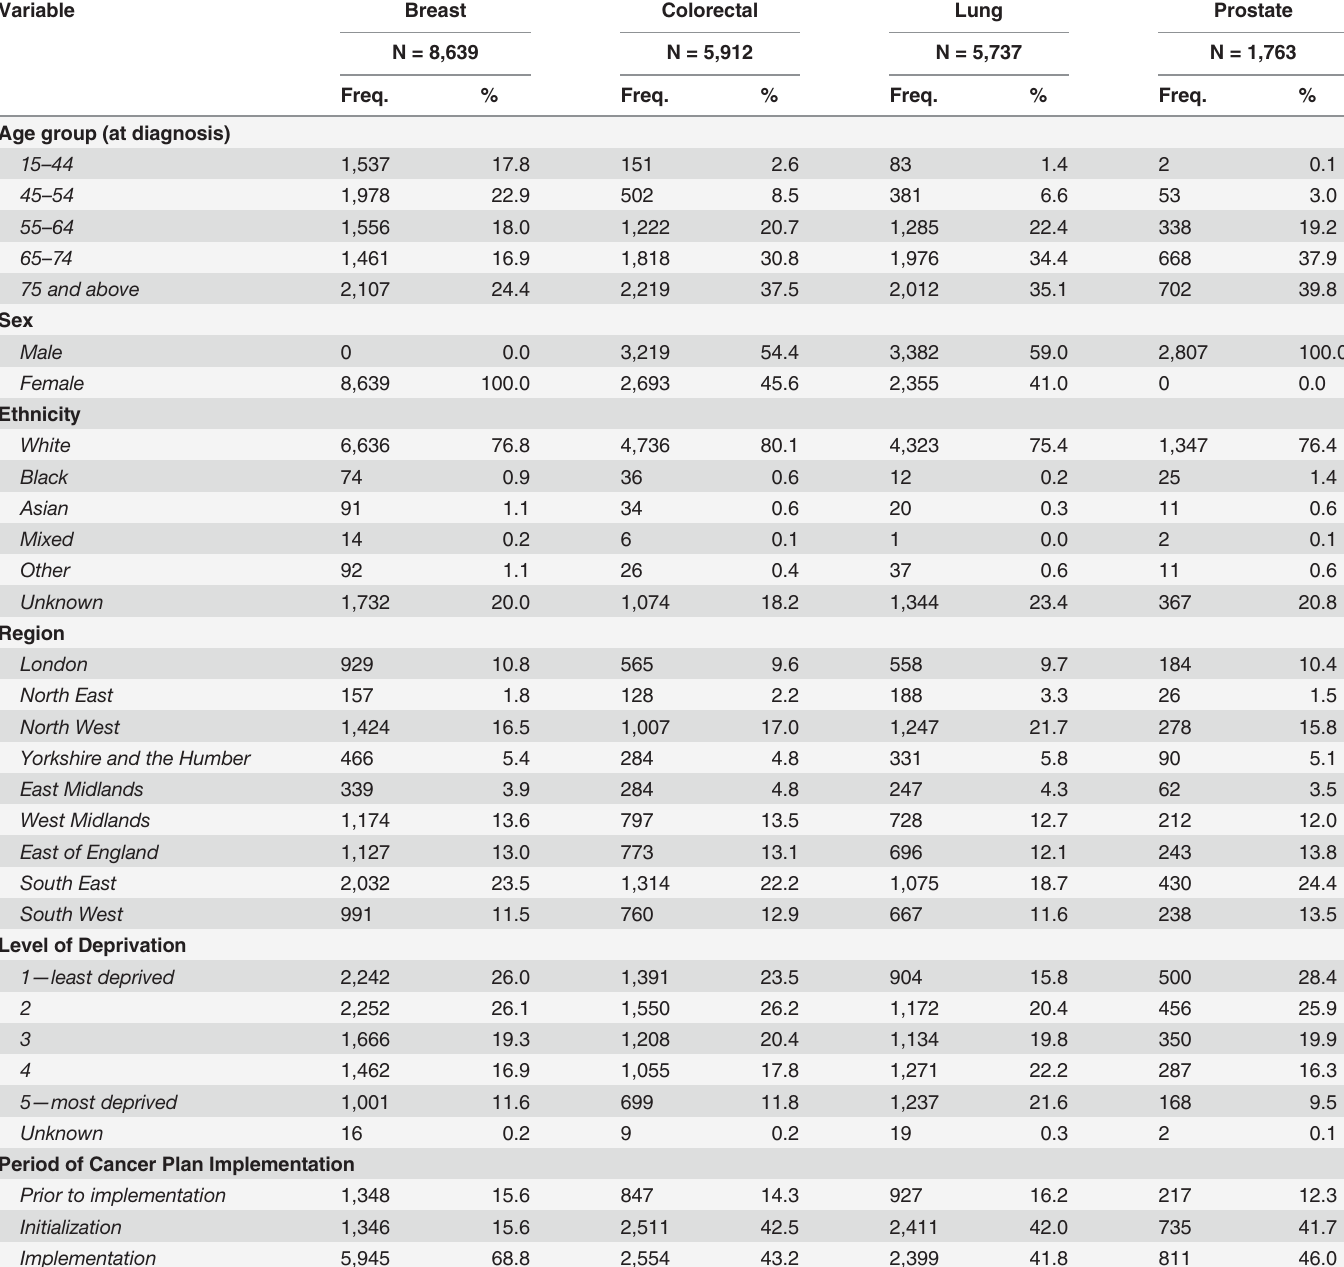
Table 1. Socio-demographic characteristics of patients by cancer site. Variable Breast